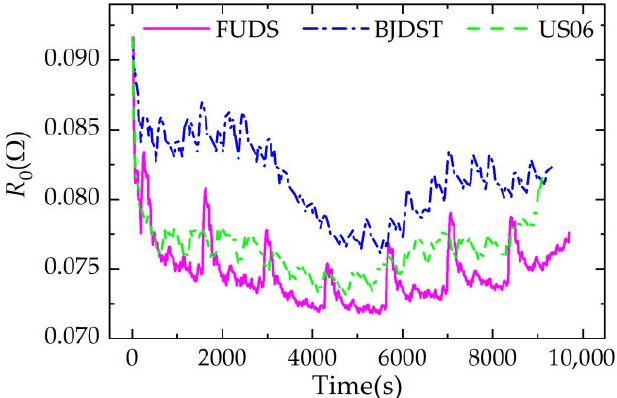
Figure 13. Identification curves of R 0 by MIUKF-FSRCKF. (The identified R 0 by AGA is increased by 20% as the initial value of R 0 .)